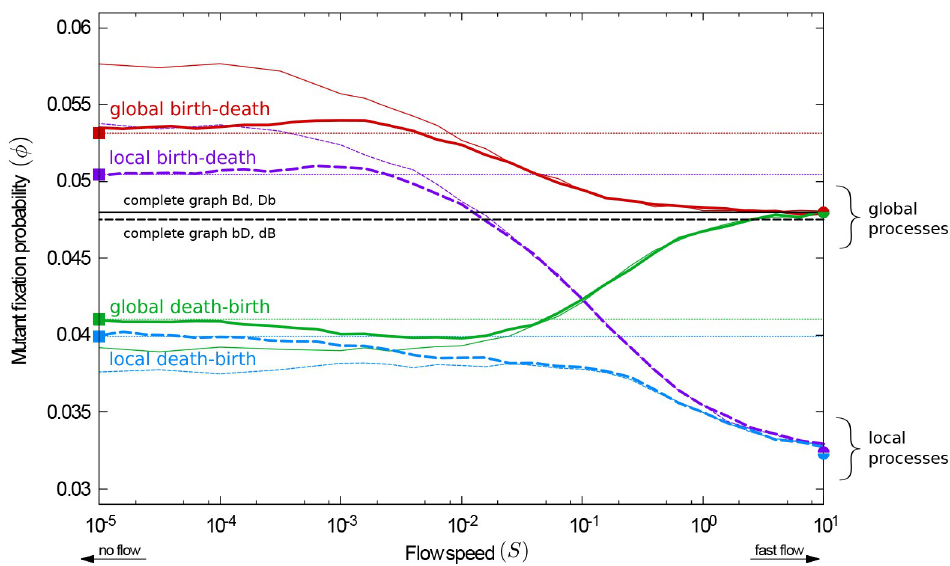
Fig 5. Comparison of fixation probability for simulations started from unrestricted and connected random geometric graphs (RGGs and CRGGs, respectively). The fixation probability as a function of the flow speed is shown as thick lines for simulations started on connected graphs; thin lines are for unrestricted initial positions (some of this data is also shown in Fig 2). Square markers indicate the fixation probabilities on static CRGGs; see text for details. The fixation probability on complete graphs is shown for reference. A minimum of ϕ is found for the Db process; maxima are discernible for Bd and bD when the dynamics are started from connected graphs. The effect of amplification/ suppression of selection at slow flow speeds is more pronounced for simulations initialized from RGGs than from